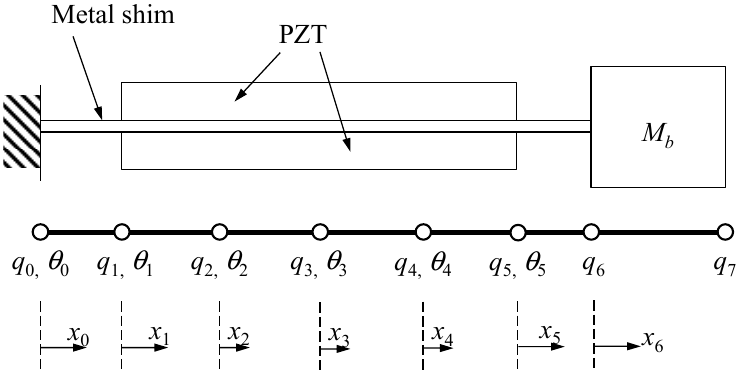
Figure 2. The beam model of the piezoelectric beam.